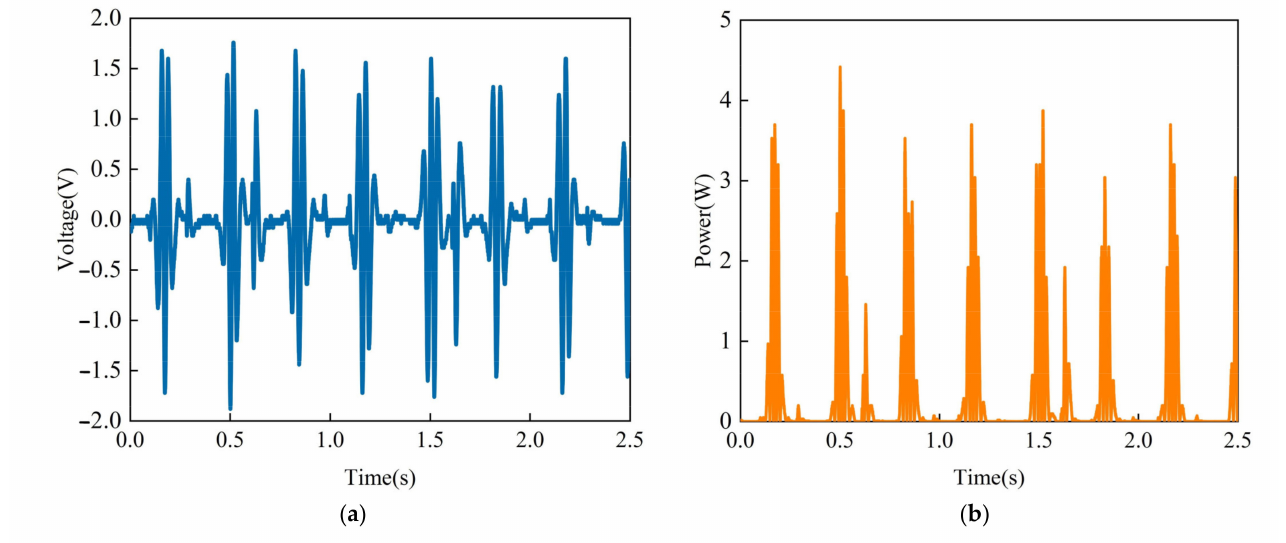
Figure 20. Damper output waveform at 3 Hz frequency and 12.5 mm amplitude connected to a 0.8 Ω external resistor. ( a ) Voltage waveform. ( b ) Instantaneous power